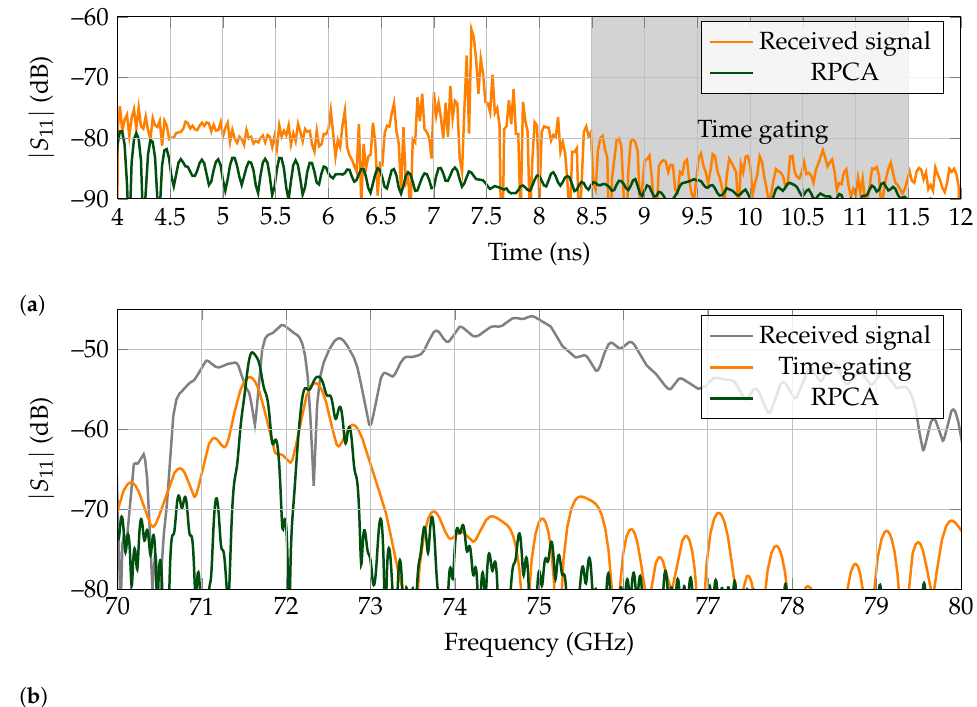
Figure 13. Received backscattered results for a high-Q landmark for measurements performed in a corner of the laboratory. ( a ) Time response. Time gating is performed between 8.5 ns to 11.5 ns. ( b ) Frequency